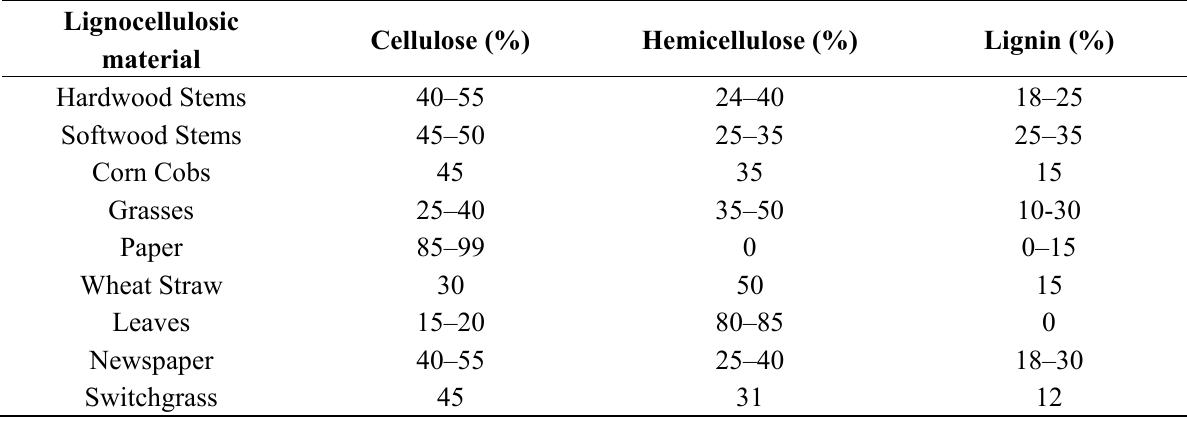
Table 1. Composition of Lignocellulosic Biomass [18,19]. Adapted with permission from Kumar et al. [19]. Copyright 2009 American Chemical